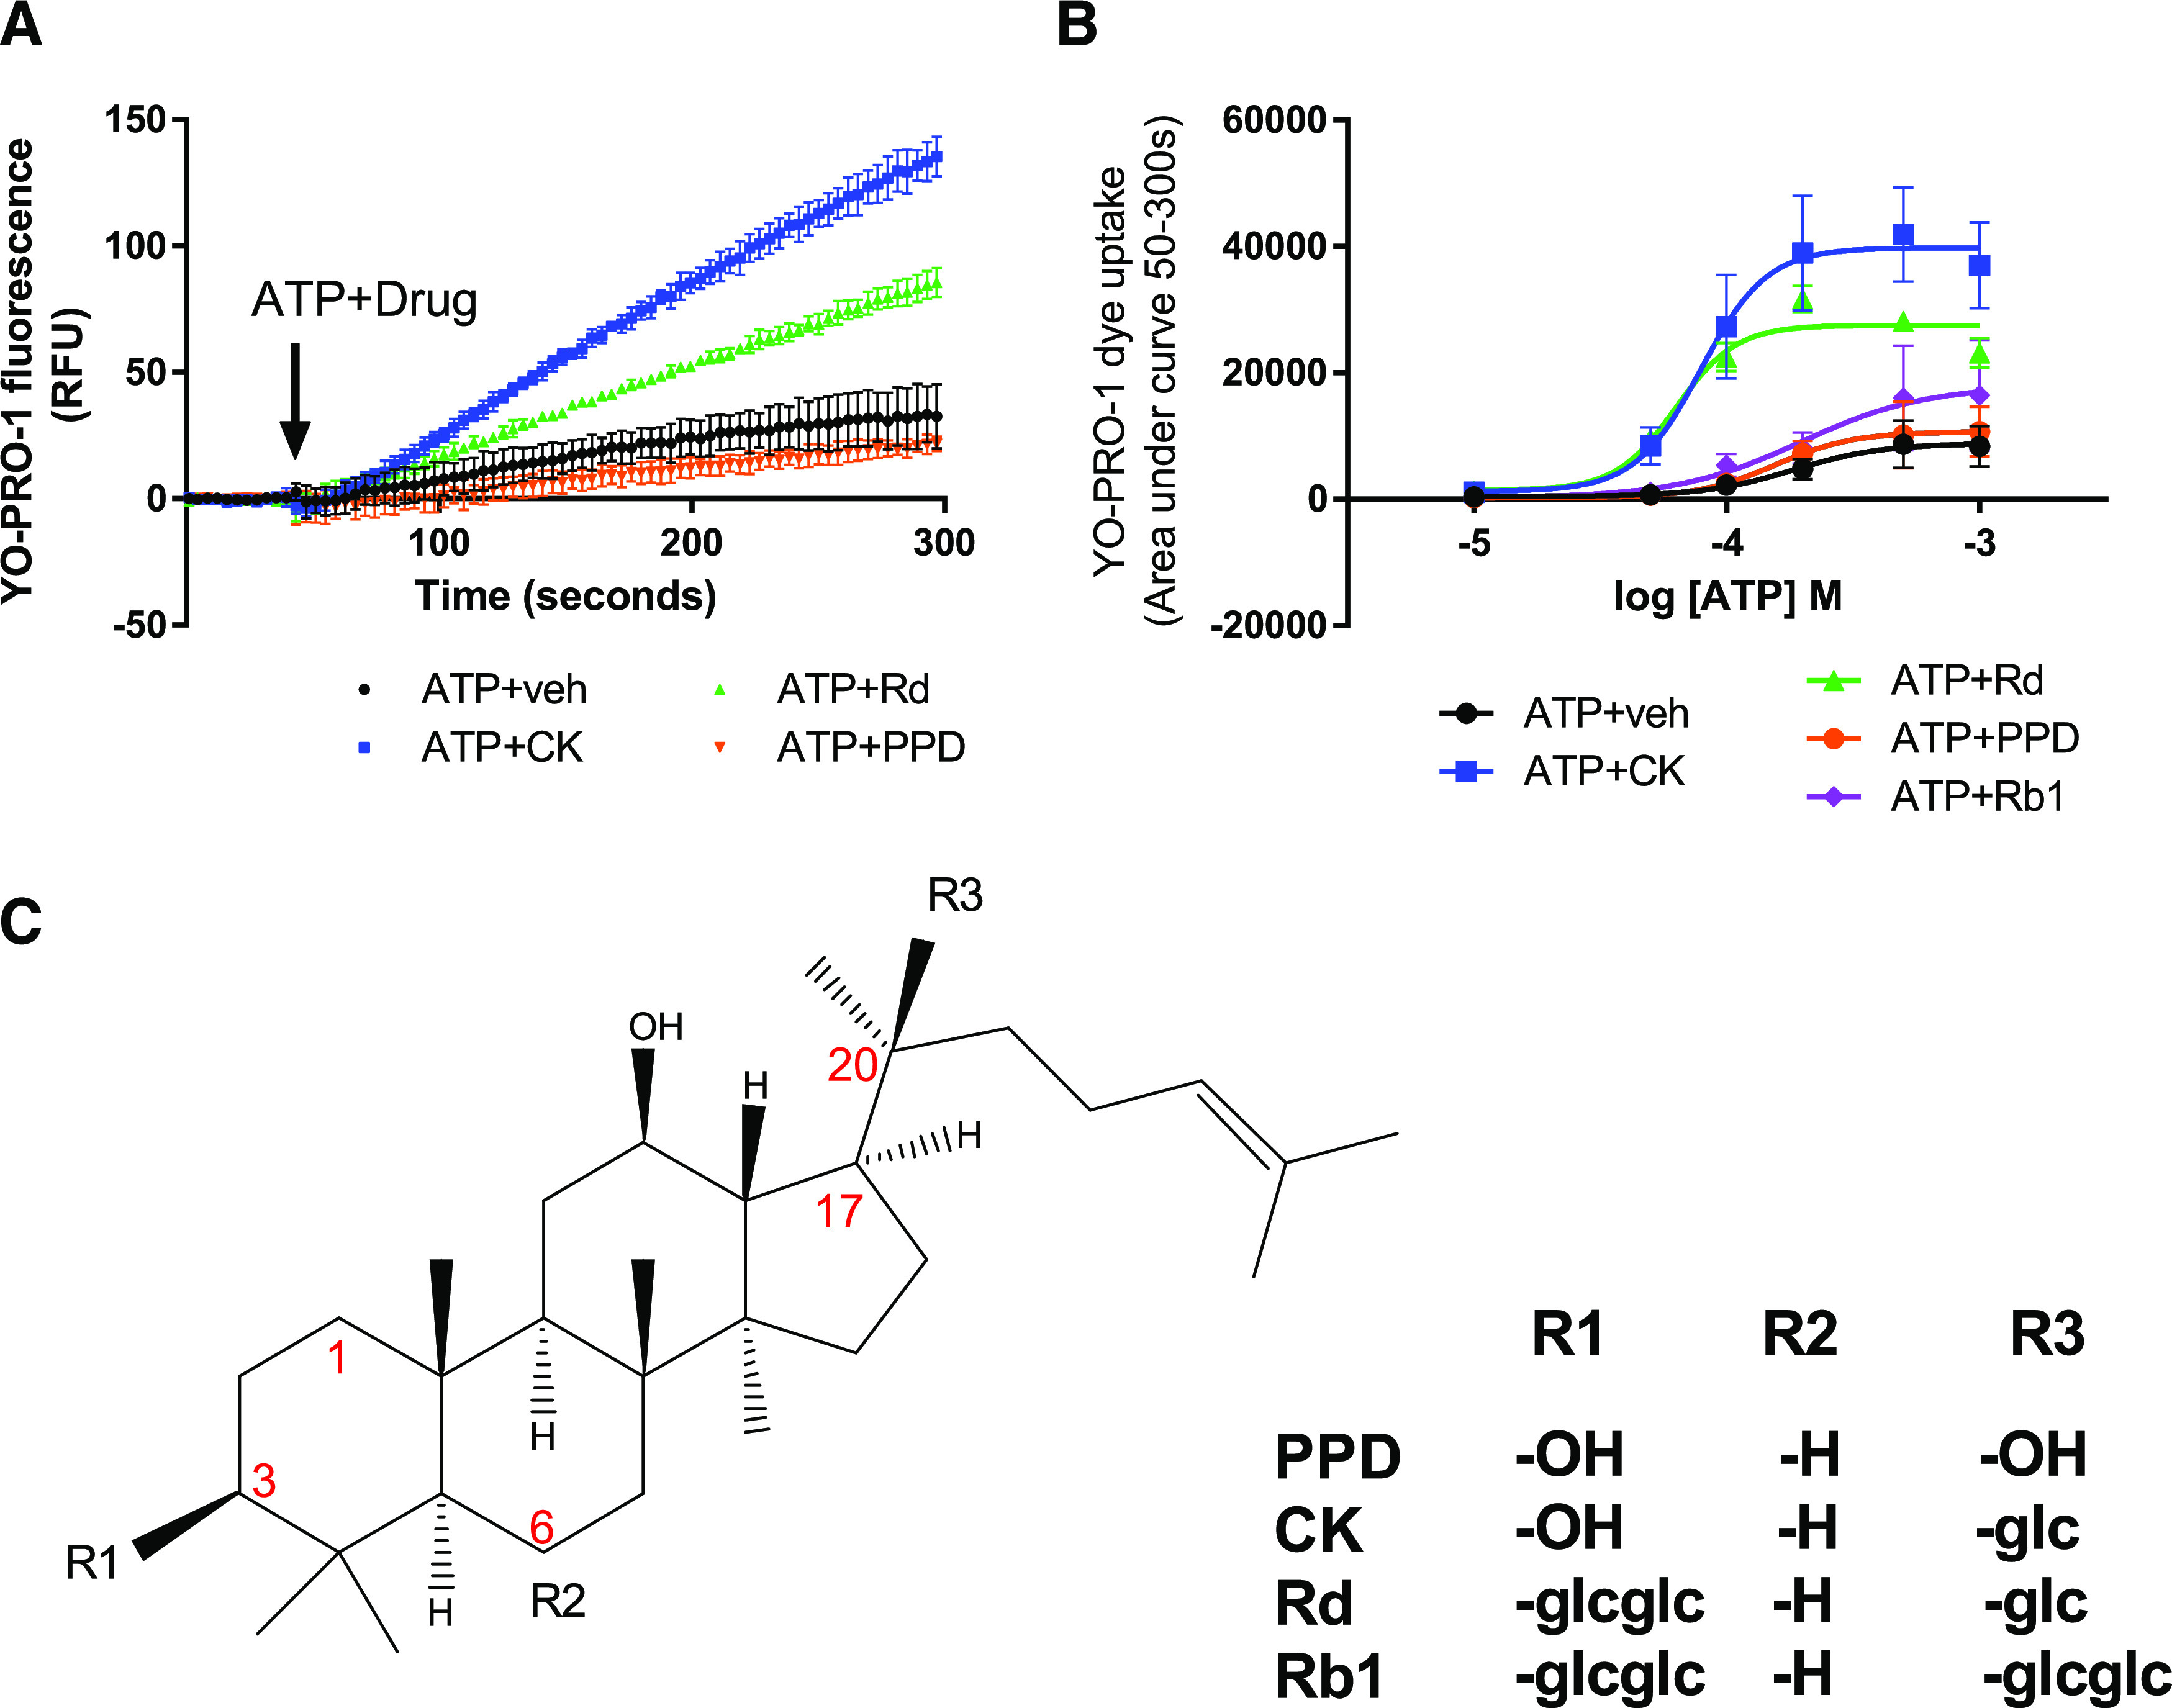
Positive allosteric effects of protopanaxadiol ginsenosides on P2X7. (A) A YO-PRO-1 iodide uptake assay was used to determine the effect of multiple ginsenosides on human P2X7 stably expressed in HEK-293 cells. Agonist (ATP, 200 μM) and modulator (10 µM) or vehicle (veh) were premixed at 10× final concentration and auto-injected together (coinjection) using a Flexstation 3 multimode plate reader. YO-PRO-1 dye uptake (relative fluorescence units (RFU)) was measured over 300 seconds. Data are expressed as area under curve means ± S.D. (B) Dose-response curves to ATP in the absence and presence of 10 µM ginsenoside-CK, -Rd, or -Rb1 or the aglycone PPD with a four-parameter nonlinear regression. Data are collated from three independent experiments each performed in triplicate. Error bars represent S.D. (C) Chemical structures for each of the ginsenoside positive modulators and the inactive aglycone PPD are shown.